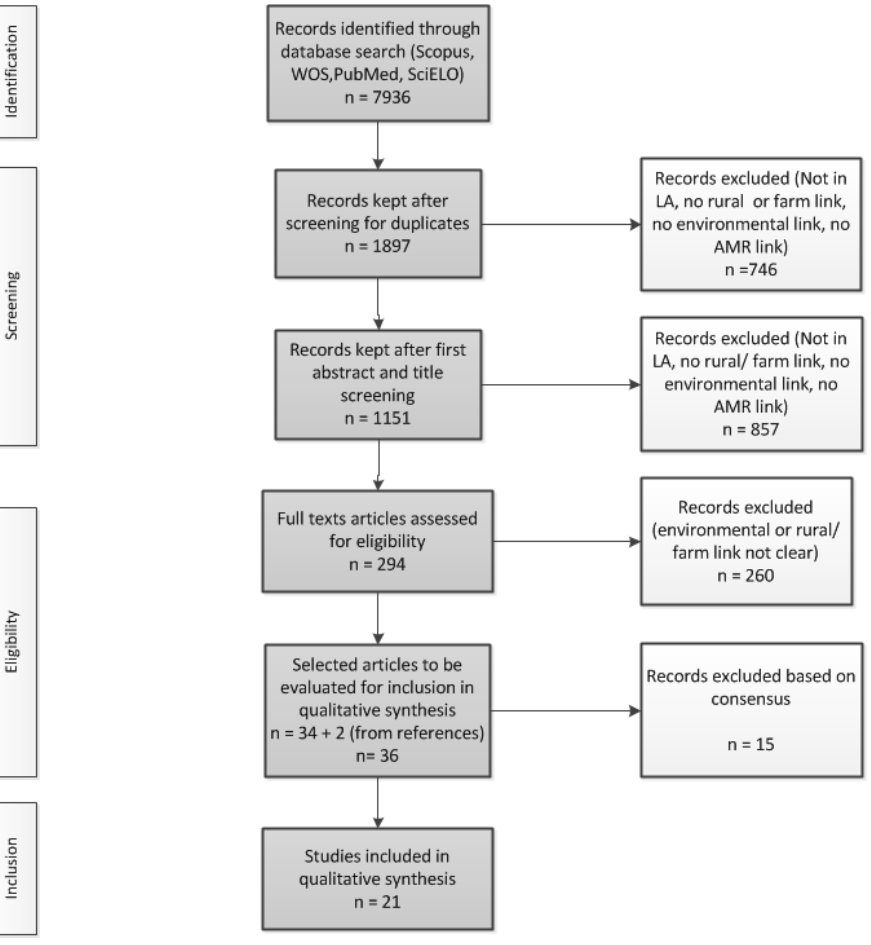
Figure 1. Flowchart of the study selection process.